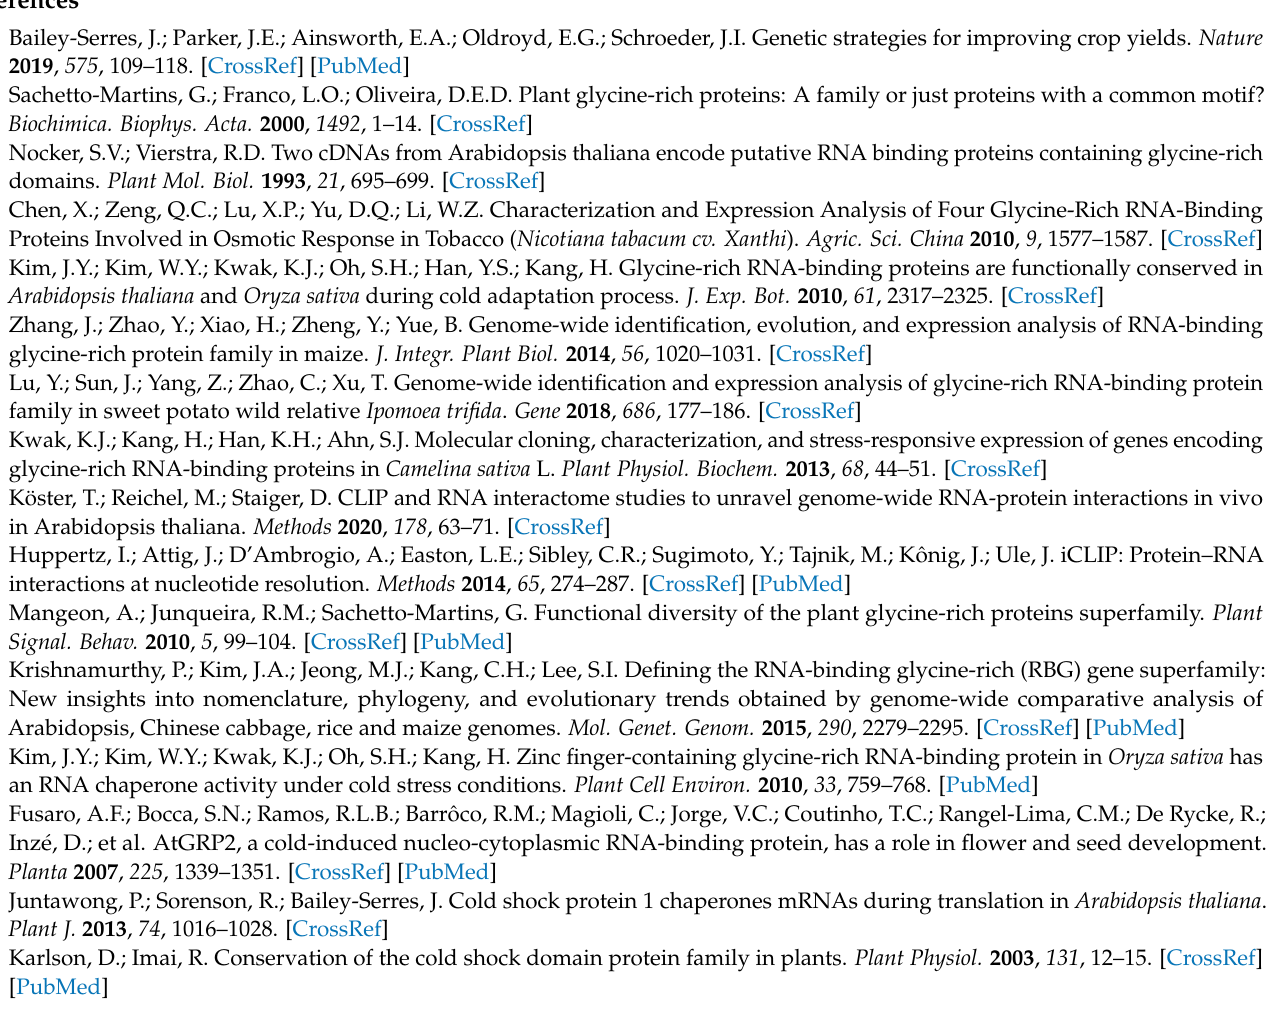
Table 1. L.M. generated Figures 1–3 and Table 2. K.C., J.L. and Z.D. revised the manuscript. All authors have read and agreed to the published version of the manuscript. Funding: This work was supported by the National Natural Science Foundation of China (31972472 and 31672208) to